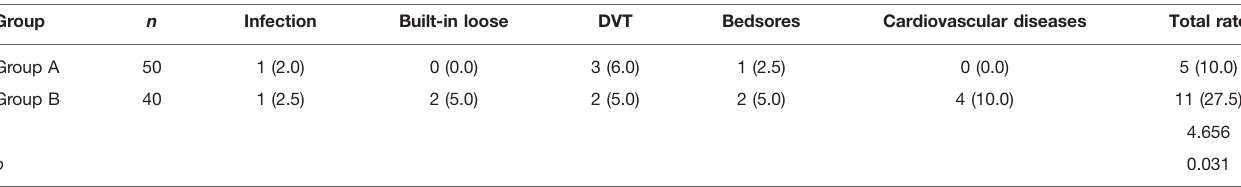
TABLE 7 | Comparison of postoperative complications between the two groups of patients [ n